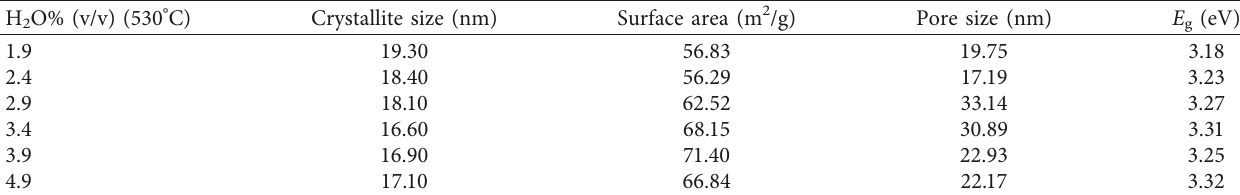
Table 2: Crystallite diameter, surface area, pore size, and forbidden energy band gap E a function of the H 2 O concentration. H 2 O% (v/v) (530 °